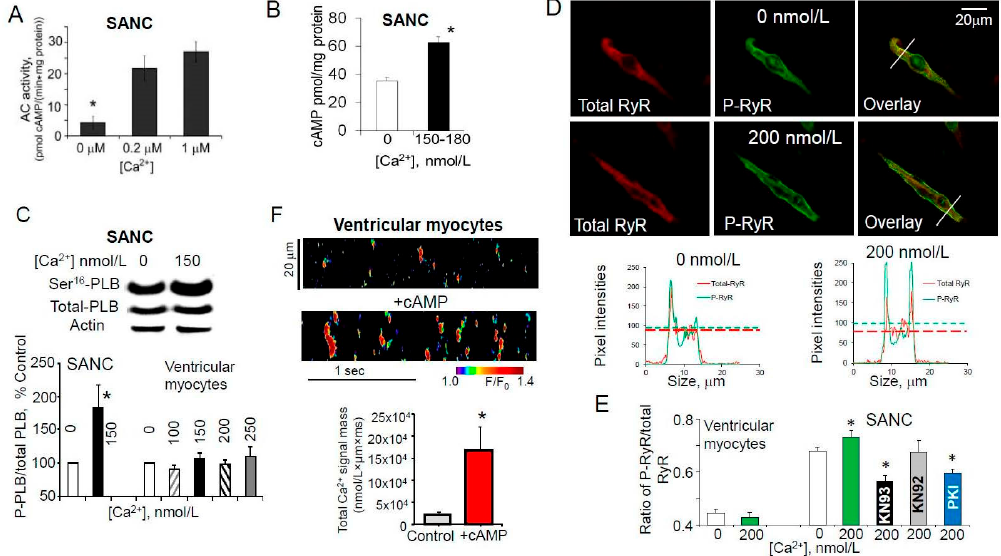
Figure 7. Ca 2+ -dependent modulation of cAMP and PKA-dependent phosphorylation in rabbit SANC, but not in ventricular myocytes. ( A ) Ca 2+ -dependent increase of AC activity of whole cell lysates of intact SANC (modified from Younes et al. [9]). ( B – E ) (modified from Sirenko et al. [35]): ( B ) An increase in cytosolic free [Ca 2+ ] f produced an increase in cAMP concentration in permeabilized SANC. ( C ) An increase in cytosolic free [Ca 2+ ] f increased phosphorylation of PLB at Ser 16 site in permeabilized SANC, but not in ventricular myocytes. ( D ) Representative permeabilized SANC immunolabeled for total and phosphorylated RyR at Ser 2809 (kept at 0 (top) or 200 nmol/L (middle) [Ca 2+ ] f respectively); pixel-by-pixel fluorescence intensities (bottom) showed that increase in cytosolic [Ca 2+ ] f produced an increase in RyR phosphorylation. ( E ) Average data of changes in RyR phosphorylation at Ser 2809 produced by an increase in cytosolic [Ca 2+ ] f in permeabilized SANC and ventricular myocytes. Ca 2+ -stimulated RyR